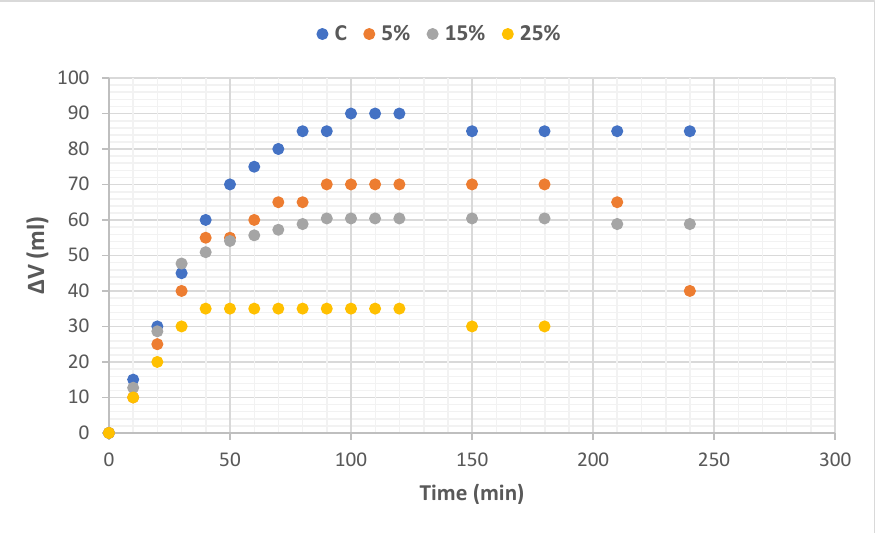
Figure 1. Fermentation curves of dough: wheat flour (control: C) and blends of wheat flour and oat flour at levels of 5, 15, and 25%.